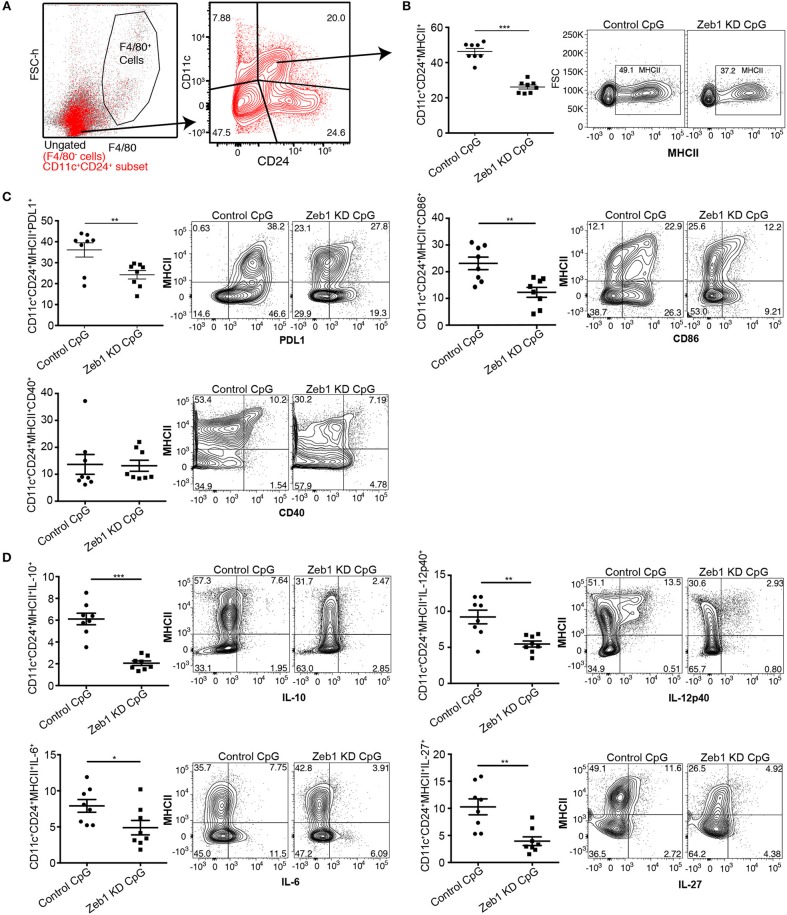
Zeb1 depletion in bone-marrow derived primary cDC1 DCs showed decreased DC activation, co-stimulation and cytokine secretion n = 6–8. (A) FACS contour-plot showing the gating strategy used to remove F4/80 positive macrophage population from the CD11c+ DCs to analyze the impact of Zeb1 KD on CD11c+CD24+MHCII+ DC population. High CD11c+CD24+ double positive DCs were considered as cDC1 DCs for analysis. (B) Scatter-plot and representative contour plots depicting the percentage of MHCII positive cells in F4/80−CD11c+CD24+ gated BMDCs treated with control and Zeb1 shRNA3 followed by 12 h CpG stimulation n = 6–8. (C) Scatter-plots and representative contour plots depicting the percentage positive cells for cell surface markers PDL1, CD86, and CD40 in F4/80−CD11c+CD24+ gated BMDCs treated with control and Zeb1 shRNA3 followed by 12 h CpG stimulation n = 6–8. (D) Scatter-plots showing the percentage positive cells for intracellular cytokines IL-10, IL-12p40, IL-6, and IL-27 in F4/80−CD11c+CD24+MHCII+ gated BMDCs treated with control and Zeb1 shRNA3 followed by 12 h CpG stimulation n = 6. p-values were calculated using two tailed unpaired student's t-test, error bars represent SEM. * ≤ 0.05, ** ≤ 0.01, *** ≤ 0.001.